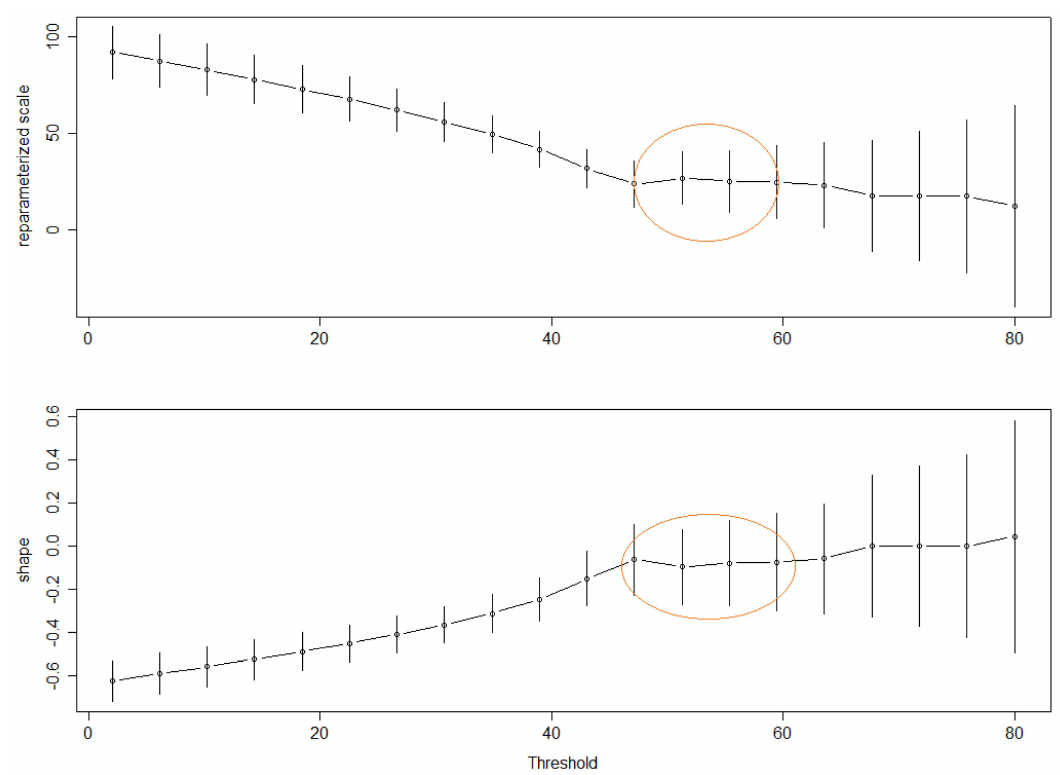
Figure A7. Parameter estimates against threshold for daily rainfall data at Lonkly station.